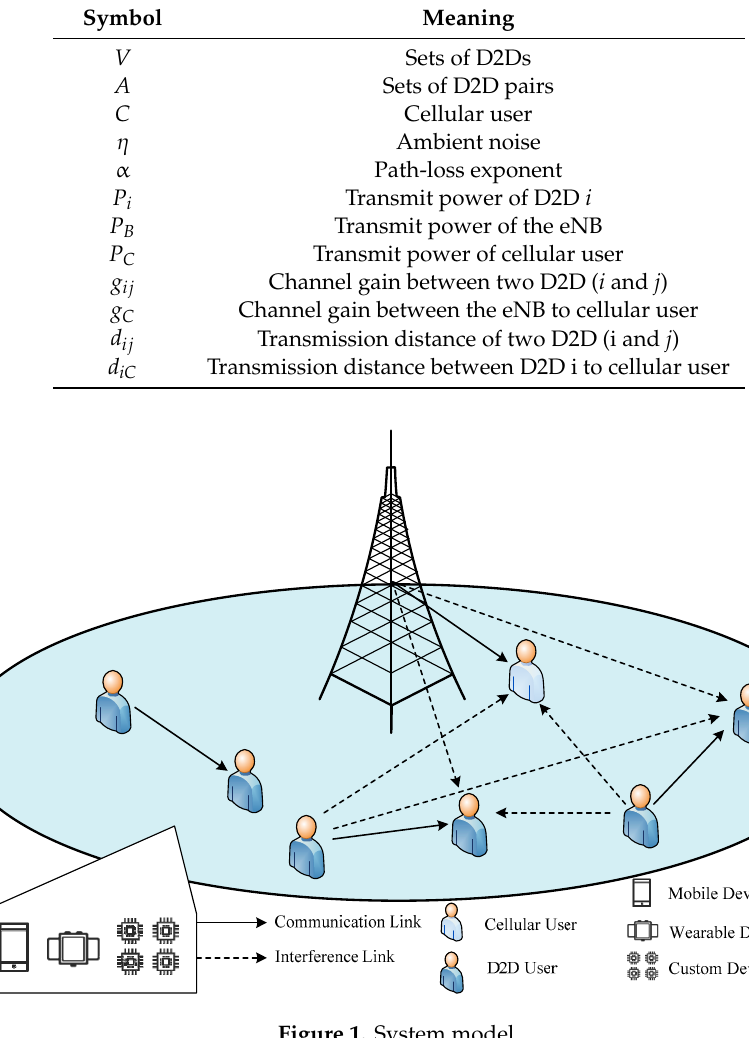
Figure 1. System model.